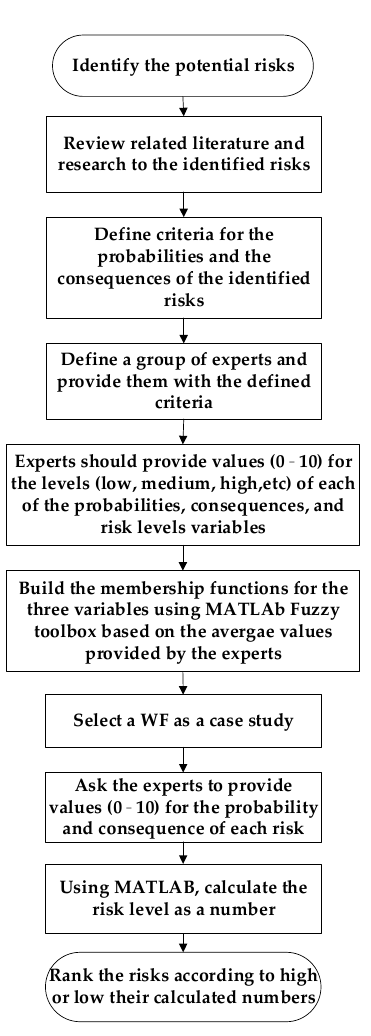
Figure 1. Methodology of analyzing risks to WFs in CCRs using fuzzy logic.